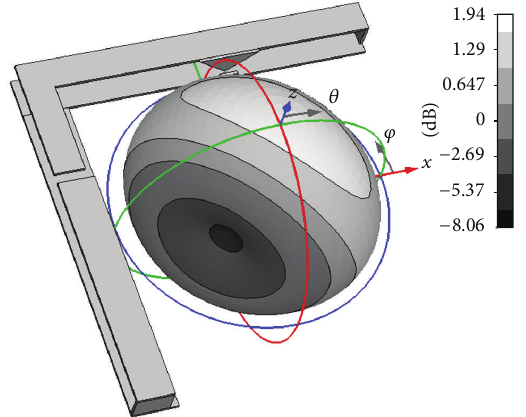
Figure 15: Simulated 3D antenna gain (dBi) for the dual-band L- shape PIFA at 670MHz.